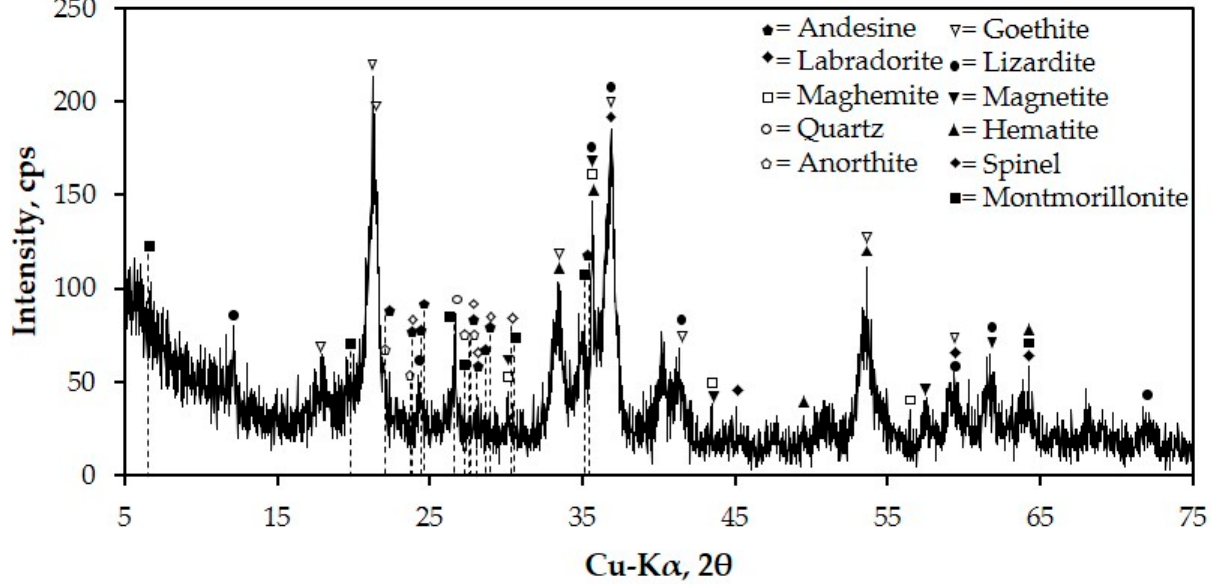
Figure 2. XRD pattern of the NMW sample. Table 2. A list of identified minerals in the NMW sample.